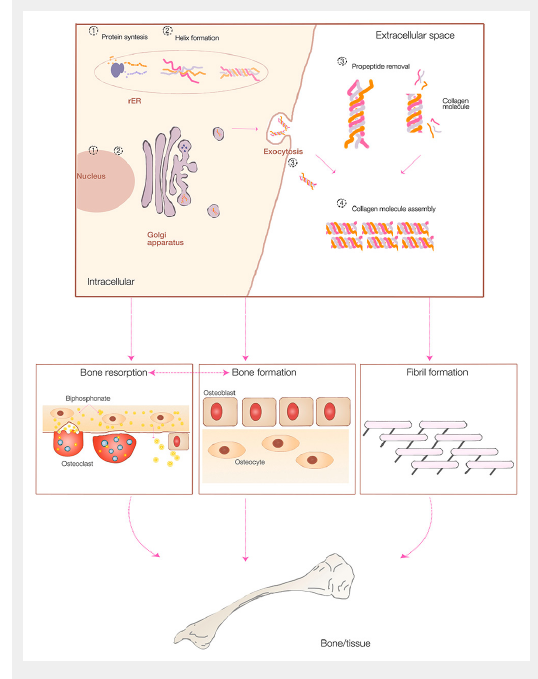
Collagen type I biosynthesis and bone formation. Collagen I is a triple helix with two alpha-1 and one alpha-2 chains encoded by COL1A1 and COL1A2 genes. After translation, the pro-alpha- chains are translocated in the rough endoplasmic reticulum (rER) where posttranslational modifications occur (1)(2). The chains are folded in a triple helix, composed of two alpha-1 and one alpha-2 chains (2). These steps are, among others, under the control of CRTAP , LEPRE 1 , PPIB and FKBP10 genes. The procollagen is then further modified during the transport to the Golgi apparatus (influence of SERPINH1 , PLOD2 and FKBP10 genes). The procollagen is then delivered into the extracellular matrix by exocytosis. There, cleavage and removal of the pro-peptides N and C results in collagen I formation (3). Crosslinking of collagen molecules leads to fibril formation. Assembly of multiple collagen type 1 fibrils leads to collagen fibres which are constituents of bone (4). Osteoblasts produce a collagen-rich extracellular matrix that will be mineralised and osteoclasts degrade bone. Bone formation and resorption is regulated through cross-talk between osteoblasts and osteoclasts. In osteogenesis imperfecta, altered quality and/or quantity of collagen I formation, altered cross-talk between osteoblasts and osteoblasts, leads to a defect in bone formation. Bisphosphonates concentrate in the mineralised osseous matrix where they inhibit bone resorption by osteoclasts.